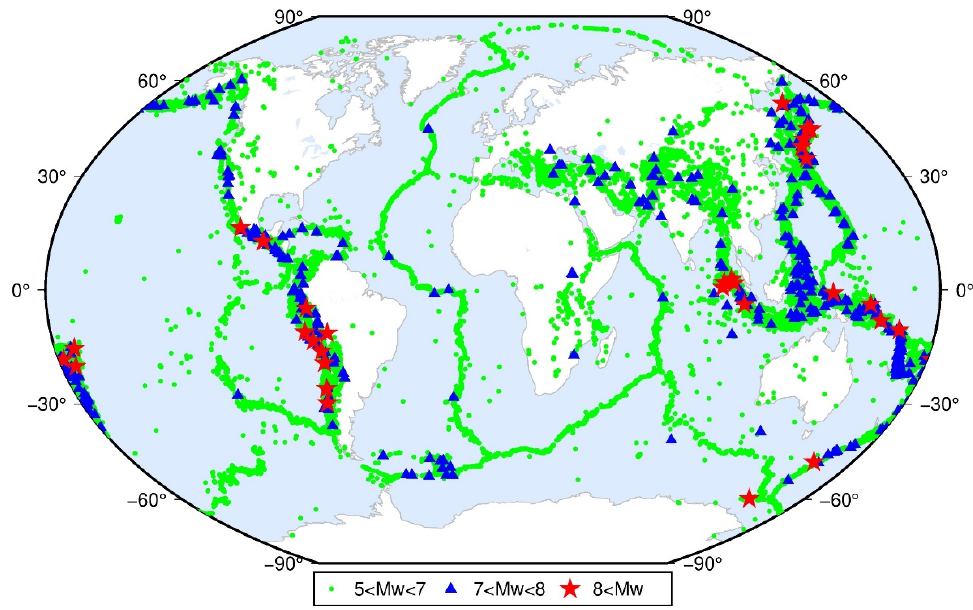
Figure 2. Distribution of global seismic events (Mw ≥ 5.0).